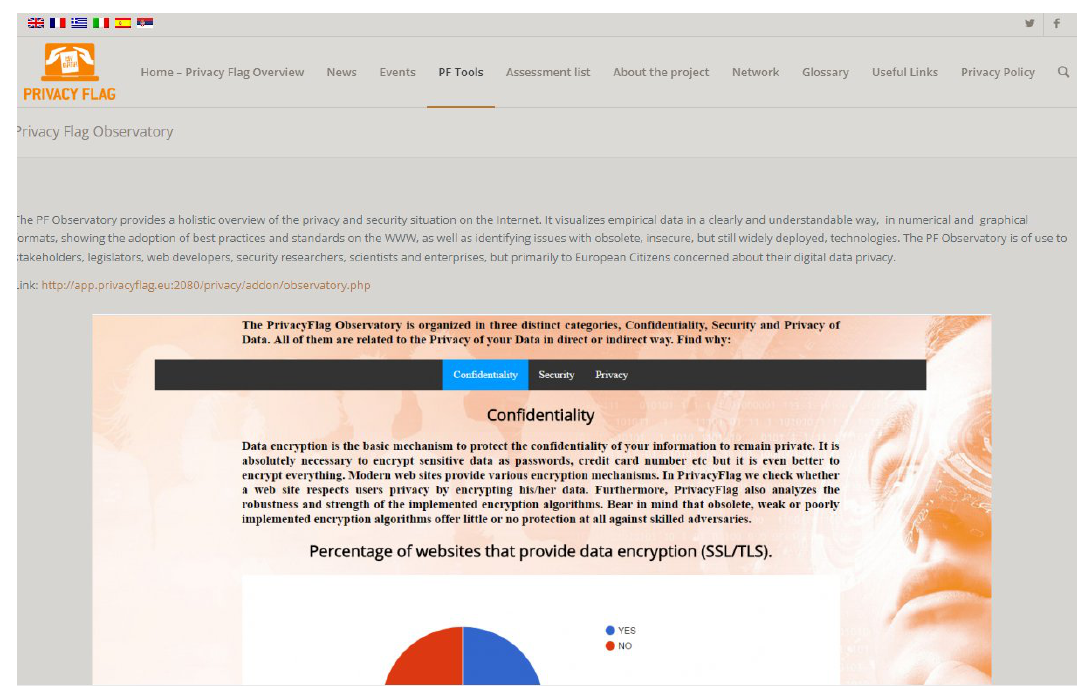
Figure 3. The initial page of the platform’s